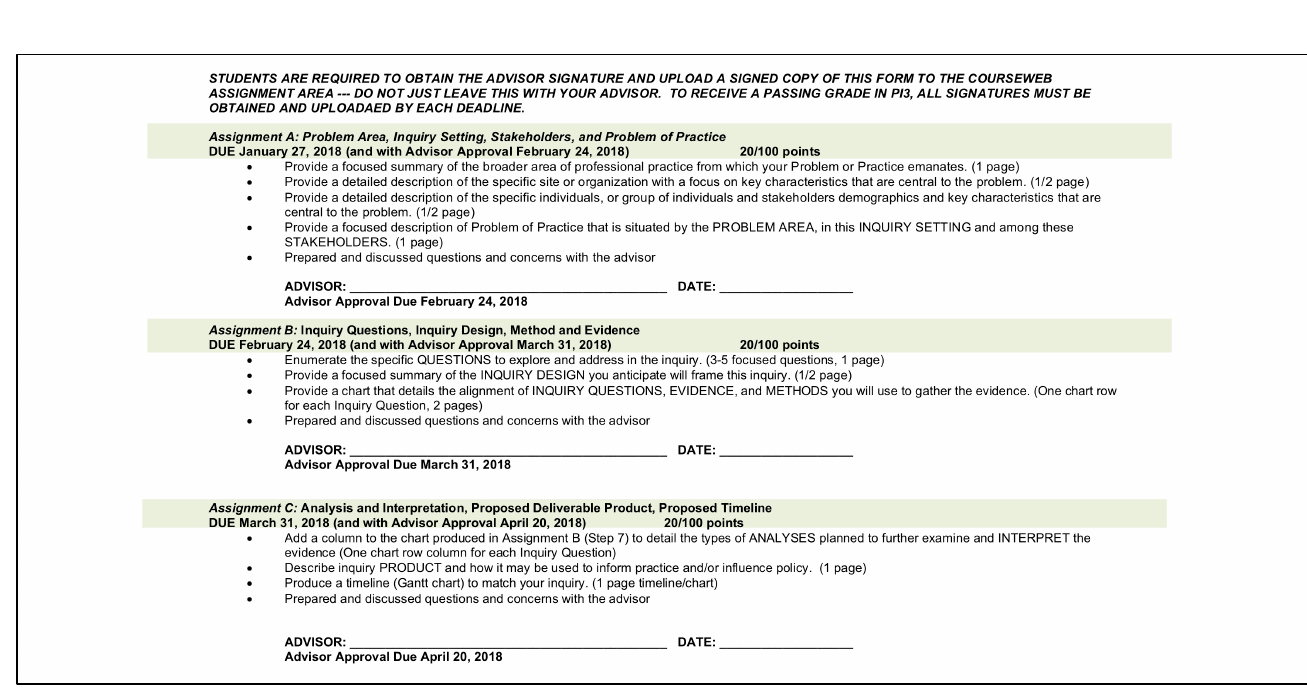
Figure 2. Practitioner Inquiry 3: Applied Inquiry Plan Assignments Advisor Sign Off